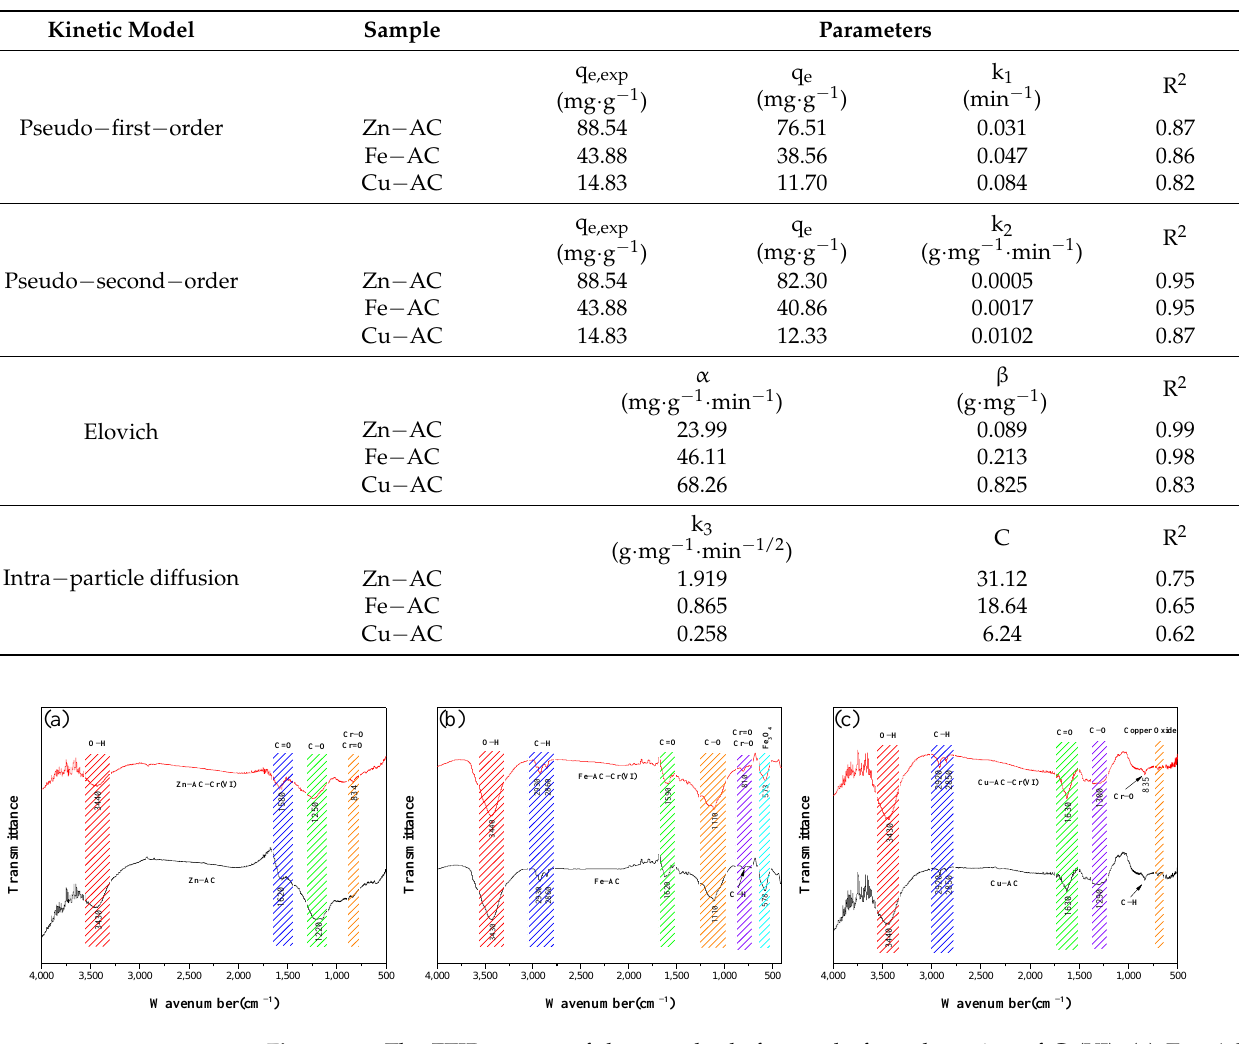
Figure 10. The FTIR spectra of the samples before and after adsorption of Cr(VI): ( a ) Zn − AC; ( b ) Fe − AC; ( c ) Cu − AC.